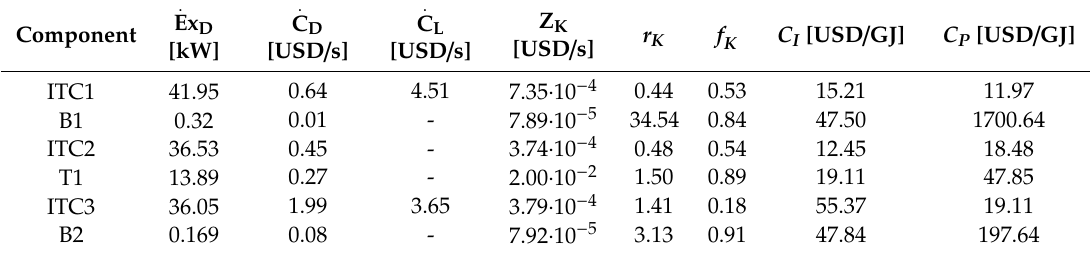
Table A3. Exergy destroyed by Component, Exergy destruction costs and Di ff erence of relative cost and exergo-economic factor by system component (Toluene).